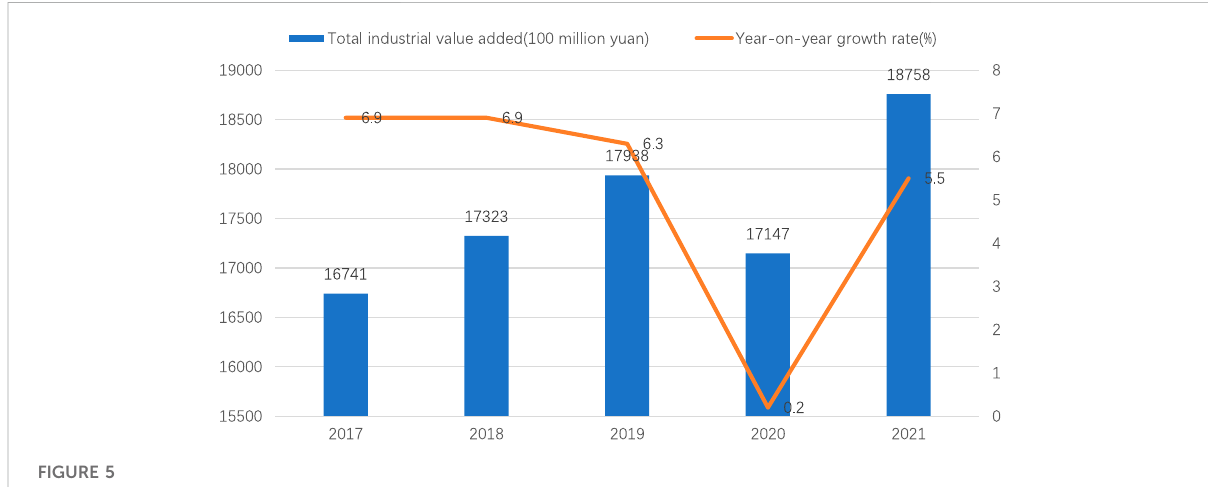
FIGURE 5 Total industrial added value of Henan Province from 2017 to 2021 and its growth